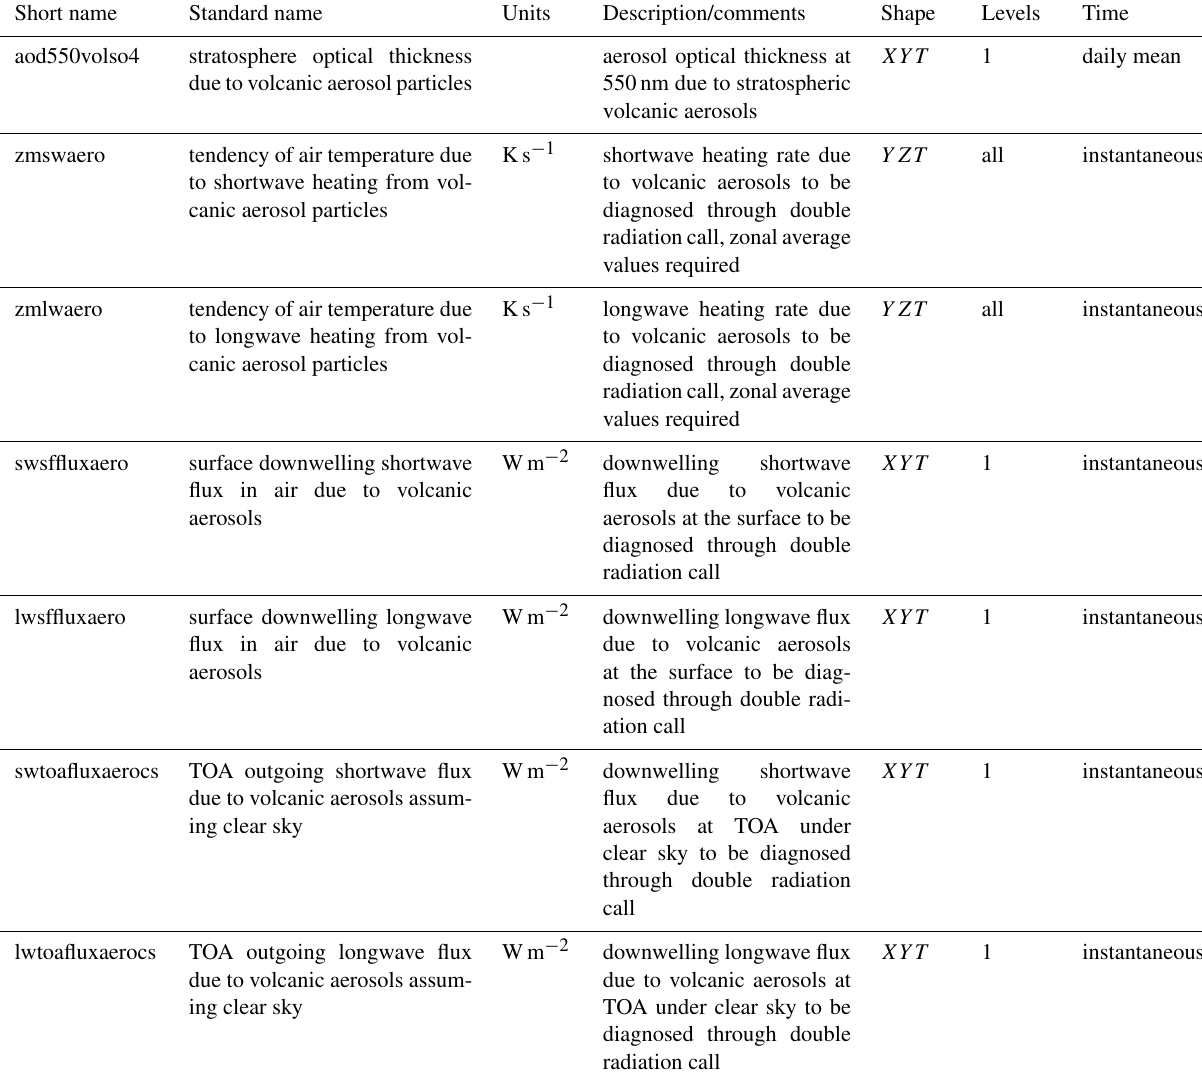
Table 4. Definition of new variables requested by VolMIP. These have not been previously used in CMIP5, CCMI, CORDEX, or SPECS. Shape is defined as time ( T ), longitude ( X ), latitude ( Y ), and height ( Z ). TOA is top of atmosphere.